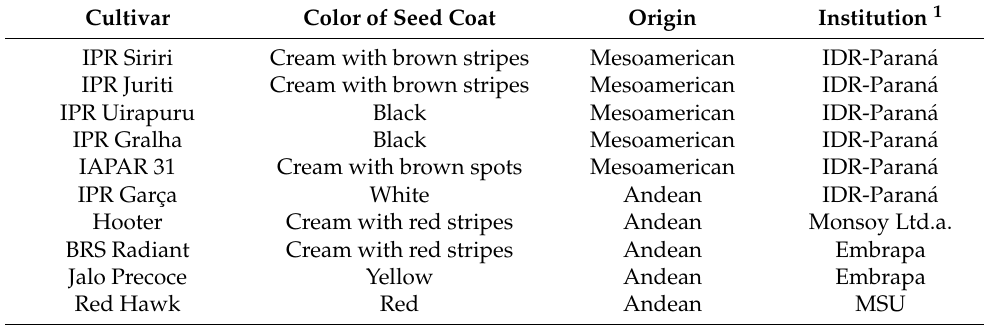
Table 2. Names, color of seed coat, origin, and breeding institutions of the 10 bean cultivars ( Phaseolus vulgaris L.) were evaluated in this study. Cultivar Color of Seed Coat Origin Institution 1 IPR Siriri Cream with brown stripes Mesoamerican IDR-Paran á IPR Juriti Cream with brown stripes Mesoamerican IDR-Paran á IPR Uirapuru Black Mesoamerican IDR-Paran á IPR Gralha Black Mesoamerican IDR-Paran á IAPAR 31 Cream with brown spots Mesoamerican IDR-Paran á IPR Garça White Andean IDR-Paran á Hooter Cream with red stripes Andean Monsoy Ltd.a. BRS Radiant Cream with red stripes Andean Embrapa Jalo Precoce Yellow Andean Embrapa Red Hawk Red Andean